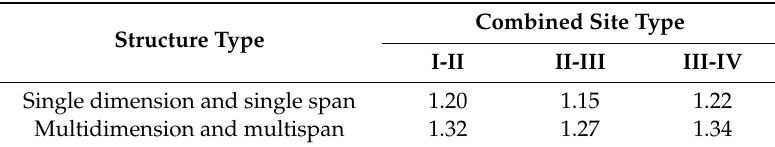
Table 4. Magnification factor of the local